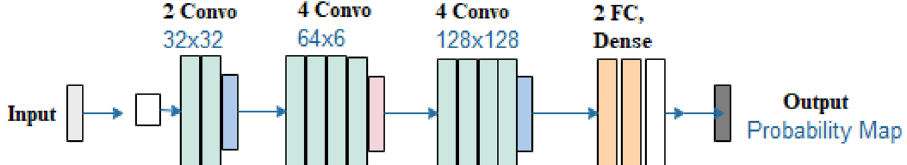
Figure 11. Neural network architecture of the Top-1 architecture optimized using EOSA-NAS model, which represents the overall best performing architecture after hundred (100) training